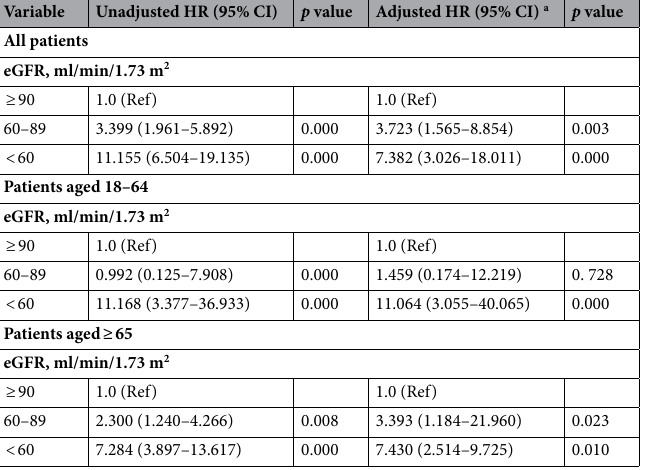
Table 6. Multivariate Cox regression analysis of associations of baseline eGFR with the mortality in patients with COVID-19. a adjusted for disease severity, hypertension, diabetes, coronary artery heart disease, cerebrovascular disease, leukocyte count, lymphocyte count, CRP, IL-6, and procalcitonin. COVID-19, coronavirus disease 2019; eGFR, estimated glomerular filtration rate; HR, hazard ratio; CI, confidence interval.